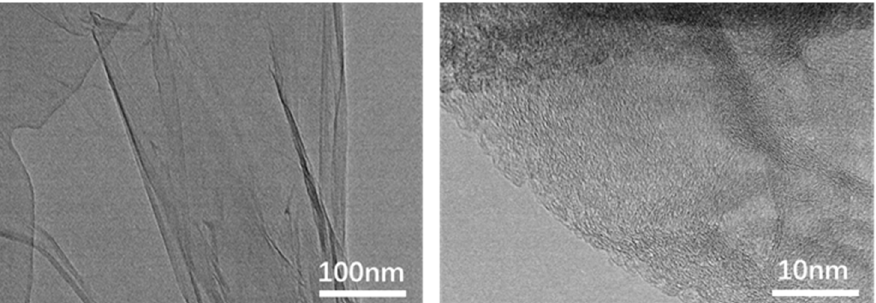
Figure 1. TEM image of GO, On the right is a HRTEM image.